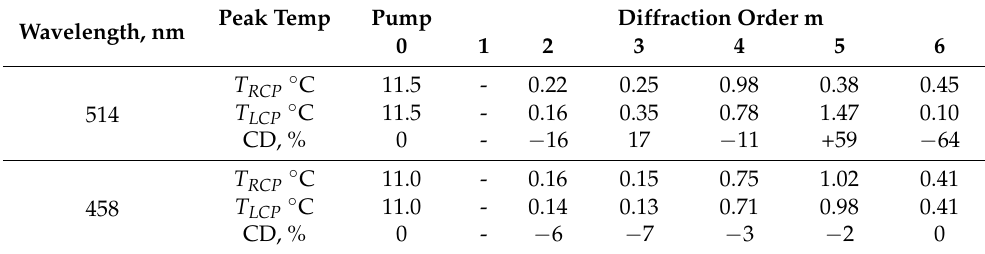
Table 3. Maximum local temperature rise for each diffracted order, as calculated by Equation (8) from PDT data in Figure 3, for excitation at 514 and 458 nm. The peak temperature is calculated for both RCP and LCP. Circular dichroism in percentage (CD%) is calculated from the temperature peaks